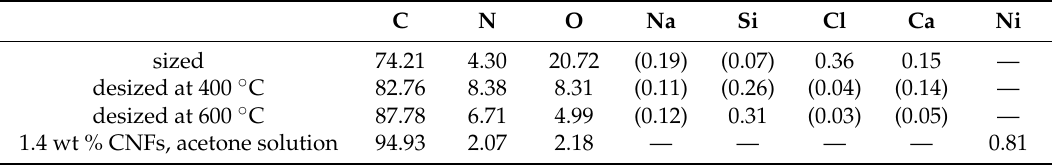
Table 3. Atomic concentrations (%, mean values) of elements shown by XPS tests. Numbers in brackets indicate elements probably not present (standard deviation larger than the